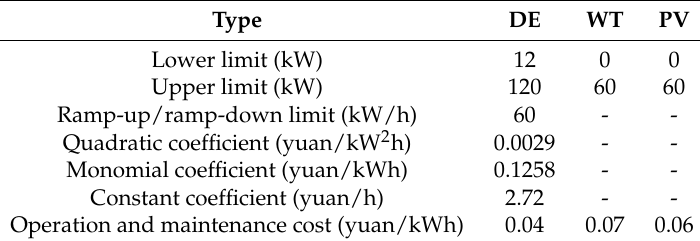
Table 1. Parameters of various